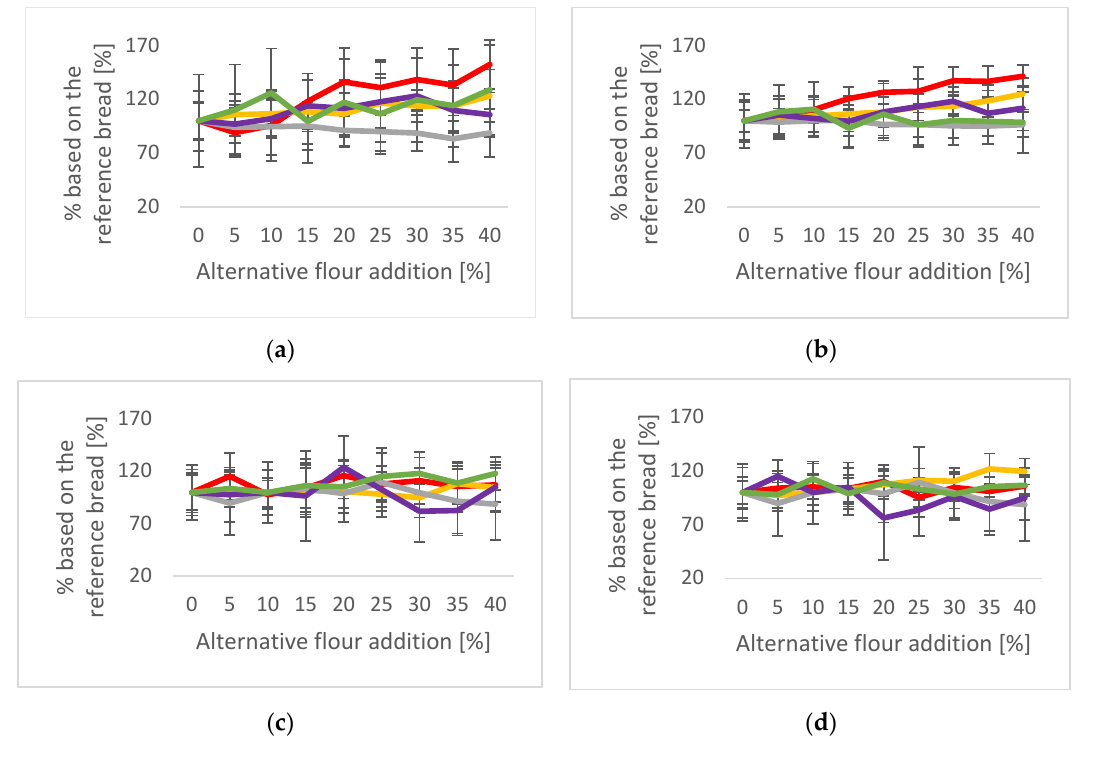
Figure 4. Pore pattern of the SWB and MWB; Red: Red sorghum, Yellow: White sorghum, Grey: Millet, Purple: Amaranth, Green: Buckwheat. This figure shows the pore properties of the different breads. The 100% wheat bread was defined as a reference. The data show the pore properties compared with the reference (100% wheat). ( a ) Change of the average pore size [%] of the SWB; ( b ) Change of the total pore area [%] of the SWB; ( c ) Change of the average pore size [%] of the MWB; ( d ) Change of the total pore area [%] of the MWB.